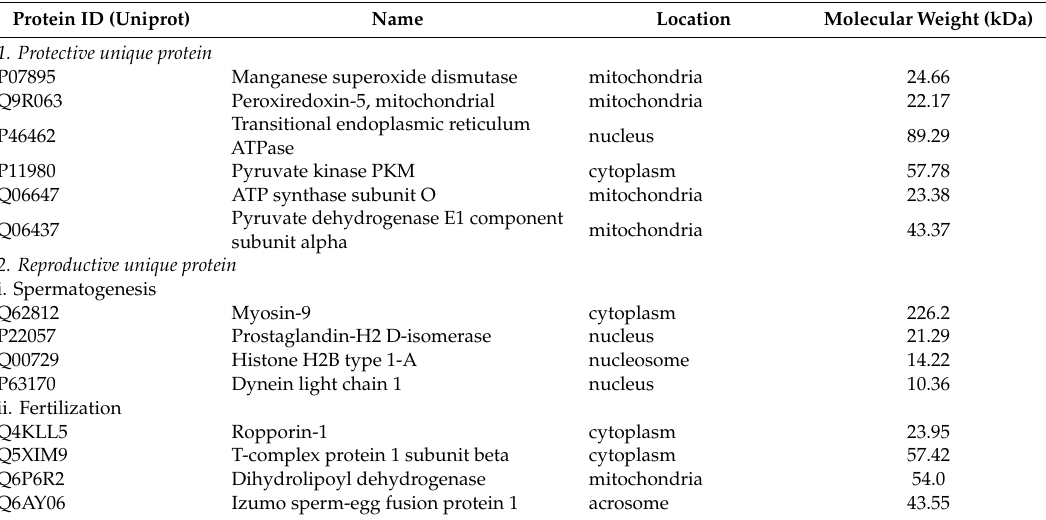
Figure 7. The number of sperm protein involved in reproductive process from normal (normal group with distilled water), negative (diabetic group with distilled water), positive (diabetic group with 300 mg/kg metformin), and FC (diabetic group with 400 mg/kg Ficus carica aqueous extract). Table 3. Classification of 14 unique sperm proteins of the FC treatment group compared to negative controls according to function based on Uniprot